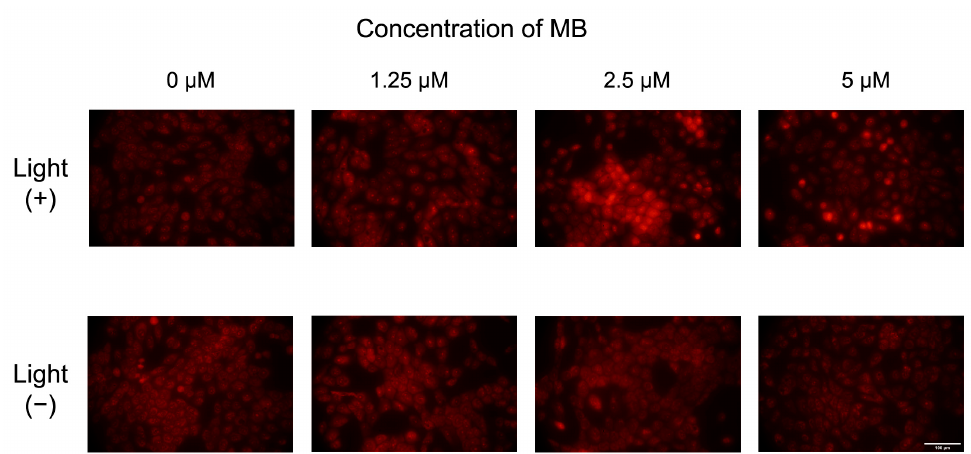
Figure 4. Fluorescence images of MET1 cells in the presence of different concentrations of methylene blue (MB) with the presence or absence of light (640 nm). The light dose applied to the irradiated cells was 2.5 J/cm². Scale bar = 100 µm.